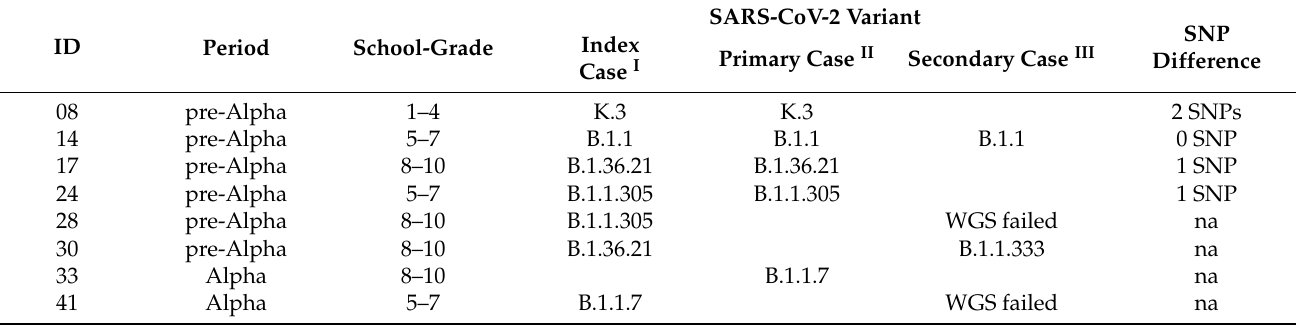
Table 4. SARS-CoV-2 variants in contact investigations in which primary and secondary cases were detected (n, 8), Oslo